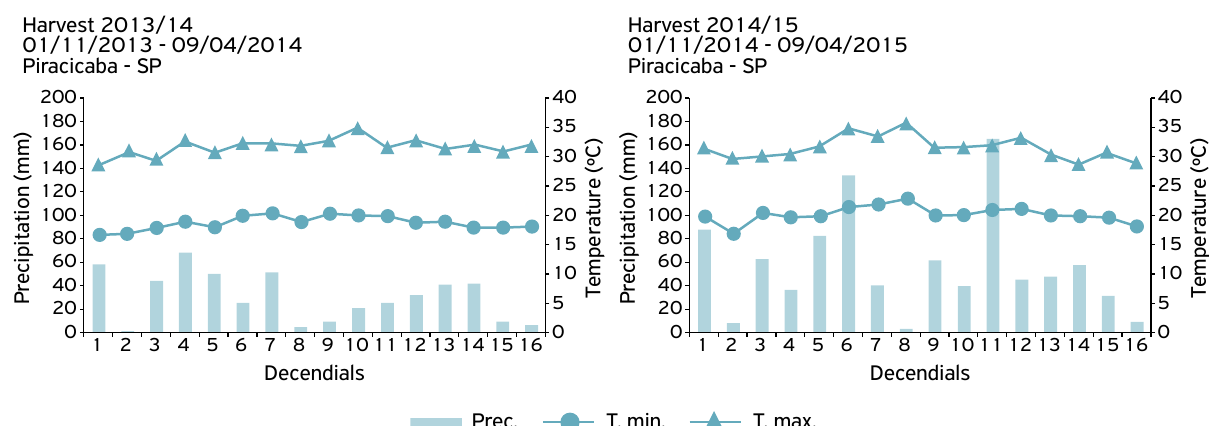
T. min. T. max. Figure 1. Representation of precipitation, average minimum and average maximum temperatures for the period relative to soybean harvest 2013/14, and 2014/15, Piracicaba (SP,